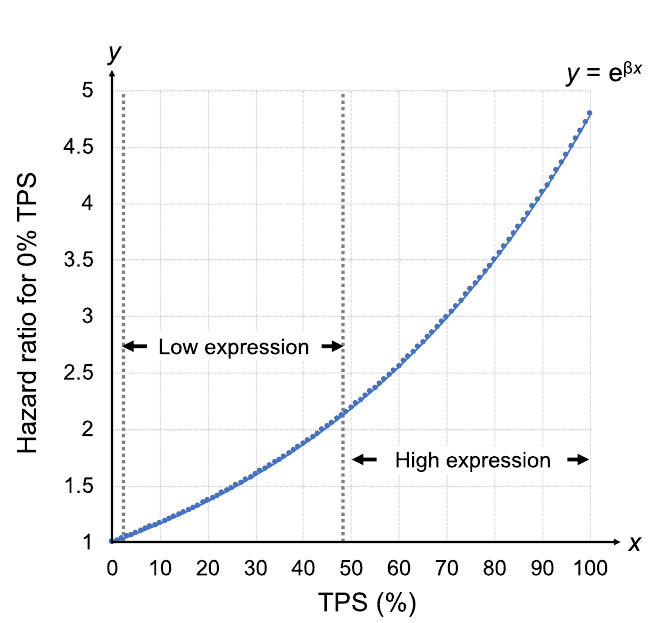
Figure 3. Hazard ratios of postoperative recurrence for each TPS value based on 0% TPS. The hazard ratio ( y ) for each TPS value was calculated based on the results of a multivariate Cox hazard proportional model with TPS ( x )—considered as a continuous variable—as the explanatory variable. Since the regression coefficient (β) for this multivariate analysis was calculated to be 0.015662, the hazard ratio was given by the value of e β , i.e.